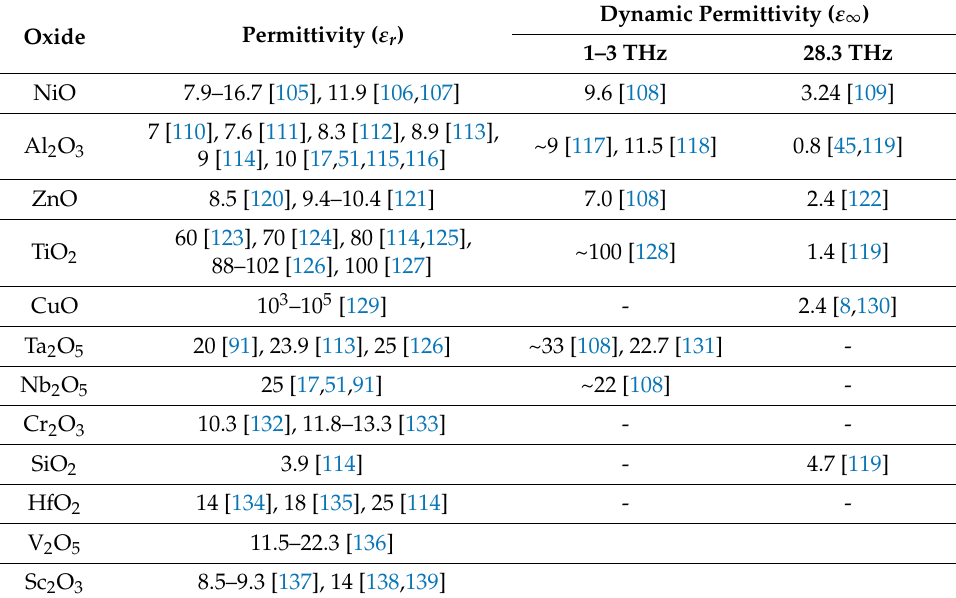
Table 4. Static and dynamic permittivity (at ~1 THz and 28.3 THz) of most common oxides used in MIM diodes for